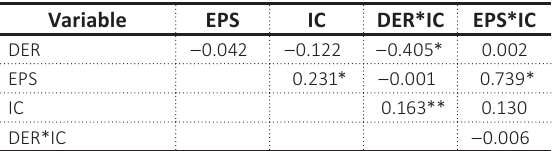
Table 3. Correlation matrix of variables